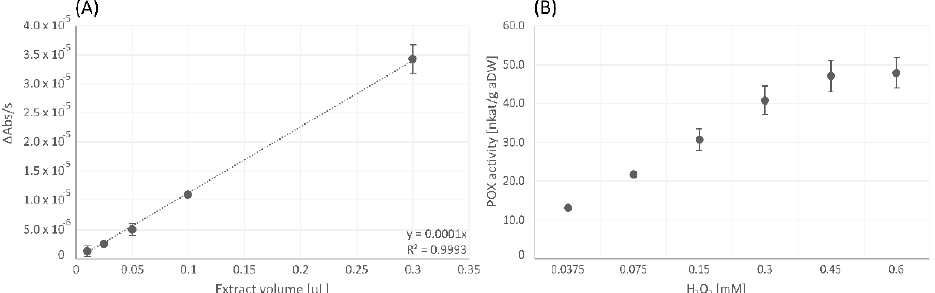
Figure 5. Dose-dependent linearity of peroxidase assay, performed with the original substrate concentration of 0.15 mM according to Fimognari et al. [43] ( A ) and variation of substrate (H 2 O 2 ) concentrations for peroxidase (POX) assay ( B ). Changes in absorbance per second [ ∆ Abs/s] ( A ) and peroxidase (POX) activity [nkat/g aDW] ( B ) are shown as mean values ± standard deviation (n = 3).